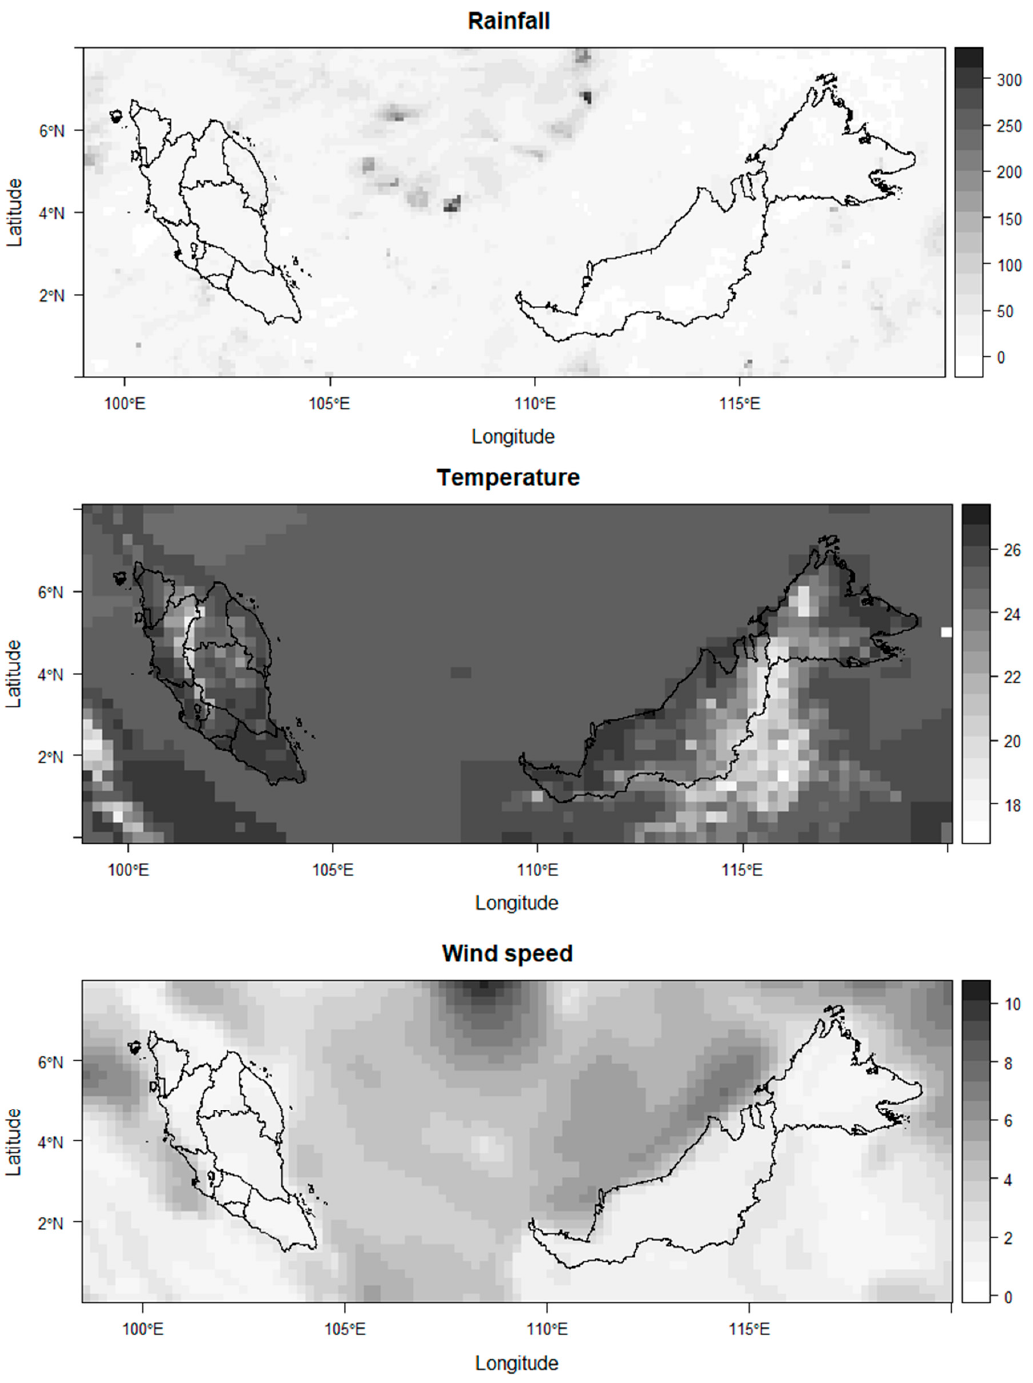
Figure 1. Raster surface for EO meteorological variables for 1 April 2019, Peninsular Malaysia. (b) Ground-based station meteorological data The ground station data for Malaysia were sourced from the National Oceanic and Atmospheric Administration (NOAA) and are available at https://www.noaa.gov/ (open source) for a duration of nine years (1 January 2011 to 31 December 2019). A total of four